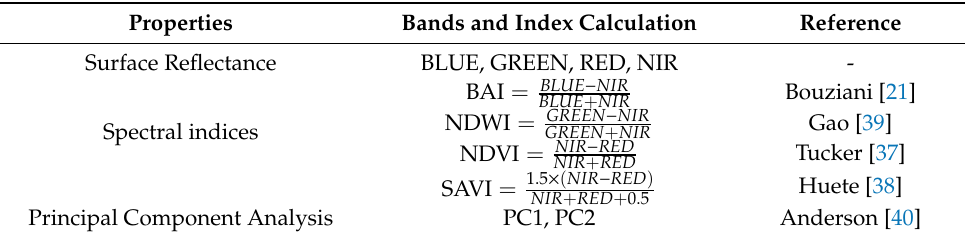
Table 3. The used bands and spectral